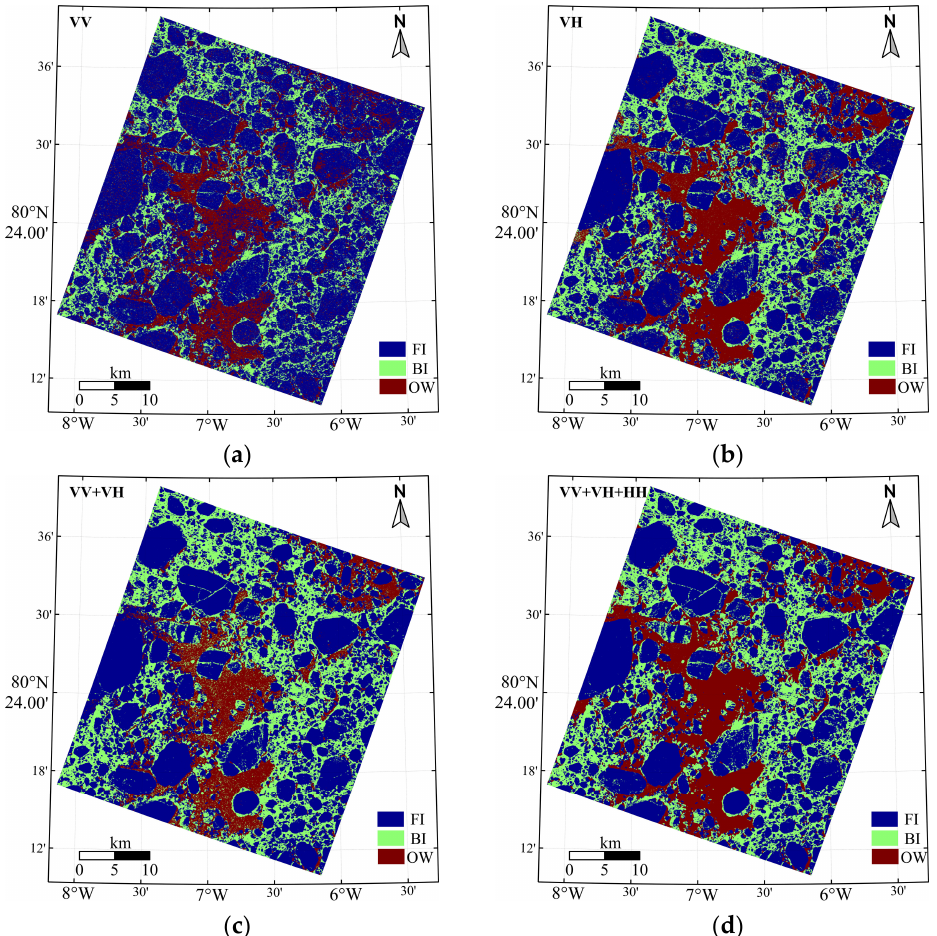
Figure 7. Sea ice classification results for the R3-15 scene (2017-06-17, 07: 37) using ( a ) VV, ( b ) VH, ( c ) VV + VH, and ( d ) VV + VH + HH polarizations with a patch size of 31 × 31. Table 3. Sea ice classification confusion matrix for the GF-3 QPS R3-15 mode data based on MSI-ResNet with different polarization combinations. Patch